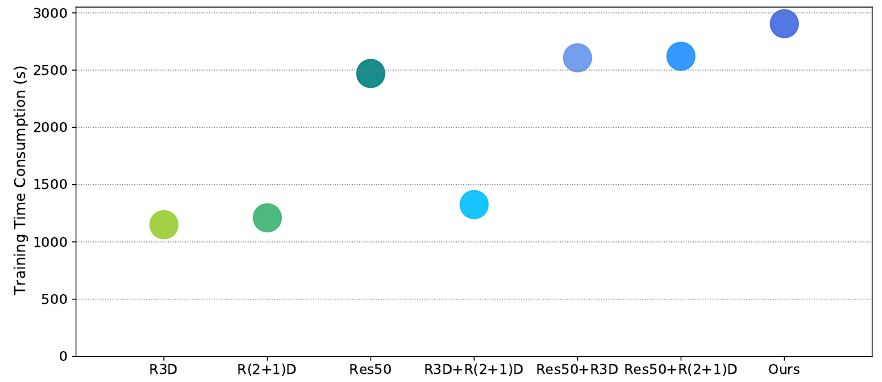
Figure 14. Time consumption in the whole training phase (40 epochs) when using different temporal or spatial features and their combinations.